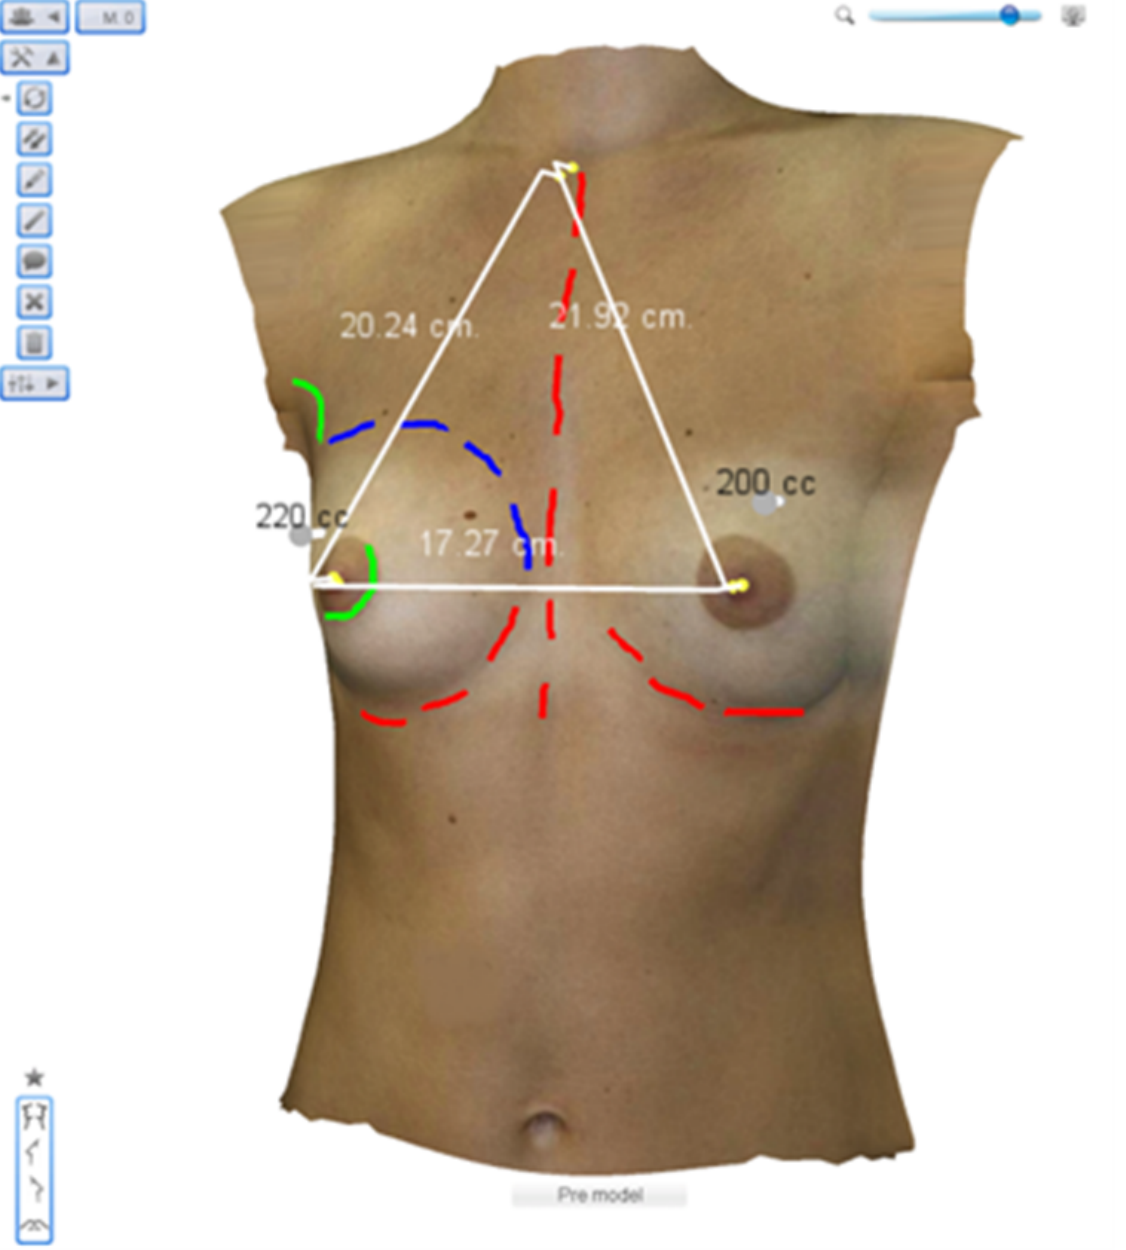
Figure 3. Web-based 3-dimensional (3D) annotations on a reconstructed patient model. A set of tools including 3D distances, text, and body drawing enable a personalized virtual clinical analysis. Cropped screenshot taken from the Web-based